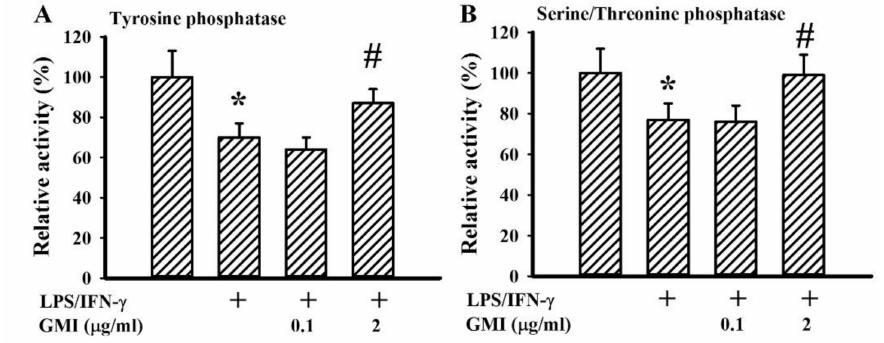
Figure 12. GMI alleviated protein phosphatase activity inactivation. Neuron/glia cultures were pretreated with vehicle or various concentrations of GMI (0.1 and 2 µ g/mL) for 30 min before being incubated with LPS (100 ng/mL)/IFN- γ (10 U/mL) for an additional 4 h. Whole cell lysates were extracted and subjected to enzymatic assay for the measurement of tyrosine phosphatase ( A ) and serine/threonine phosphatase ( B ) activity. The activity of untreated control was defined as 100%. * p < 0.05 vs. untreated control and # p < 0.05 vs. LPS/IFN- γ control, n = 4. The + means the groups treated with LPS/IFN- γ and the rest groups without + indicate vehicle